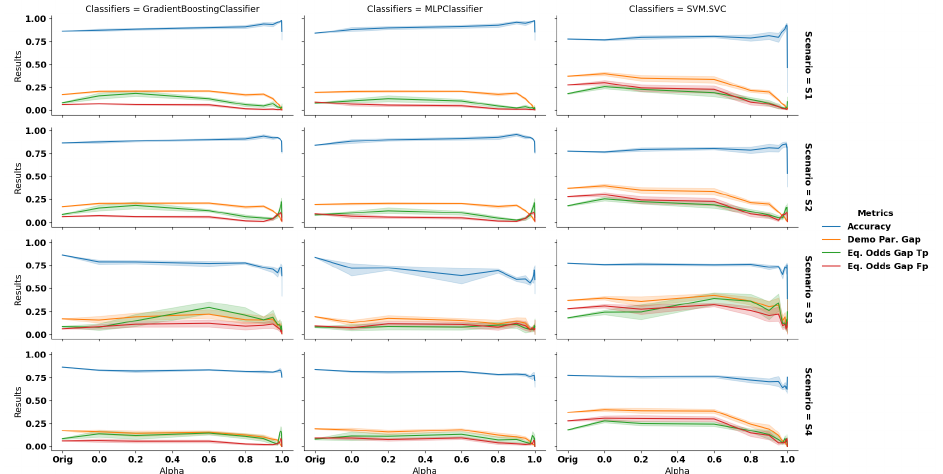
Figure 8. Accuracy (blue), demographic parity gap (orange) and equalized odds gap (true positive rate in green and false positive rate in red) computed for scenarios 1, 2, 3 and 4 (top to bottom), with the classifiers GB, MLP and SVM (left to right) on Adult dataset. The greater the value of α the better the fairness. Using only the sanitized data ¯ A ( S1, S2 ) increases the accuracy while a combination of the original ( A ) and sanitized data ( ¯ A ) decreases